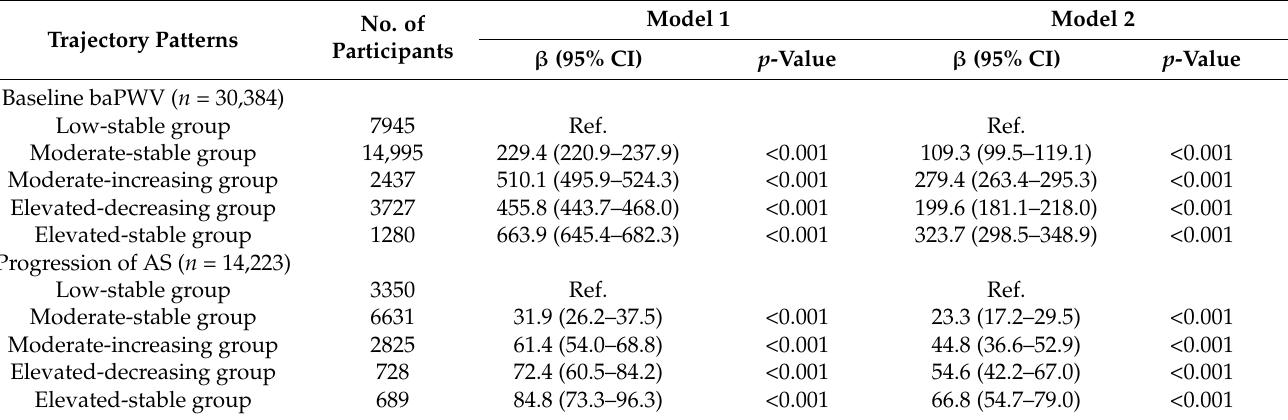
Figure 1. Systolic blood pressure (SBP) trajectory patterns for general participants from 2006 to 2010. SBP was classified into five groups according to the latent mixture modeling. The red line indicates the low-stable pattern, the green line indicates the moderate-stable pattern, the blue line indicates the moderate-increasing pattern, the black line indicates the elevated-decreasing pattern, and the yellow line indicates the elevated-stable pattern. The x-axis refers to the years of follow-up surveys of the participants. The y-axis refers to the SBPs of the participants. Table 2. Associations of SBP trajectories with the baseline baPWV and progressive baPWV.